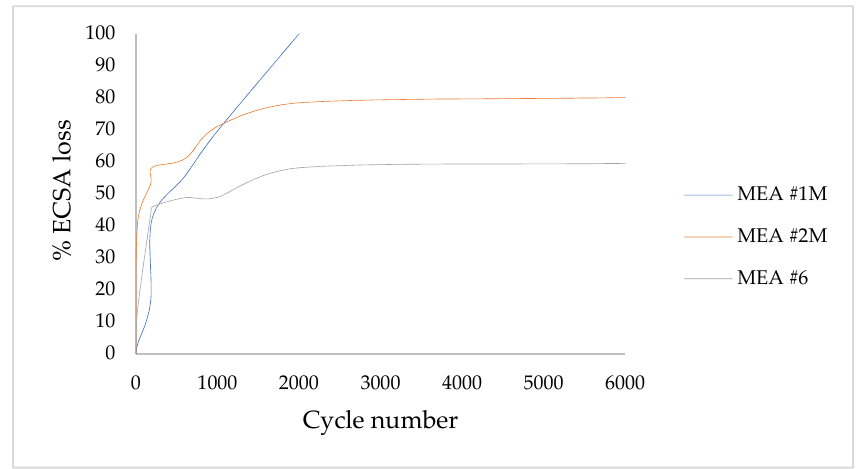
Figure 6. ECSA loss during cycling of the stratified MEA #6 and monolayer MEA #2M and MEA